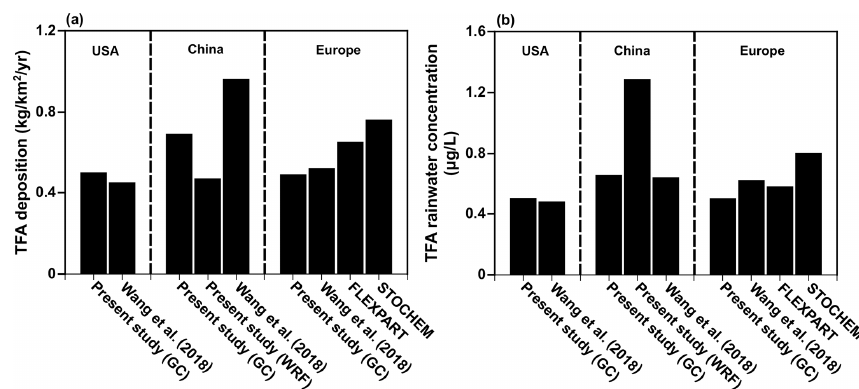
Figure 4. Comparison of the present study with other studies over the USA, China, and Europe for (a) TFA deposition and (b) TFA rainwater concentration. Note the emissions are 24.53, 42.65, and 19.16Ggyr − 1 for the USA, China, and Europe, respectively.